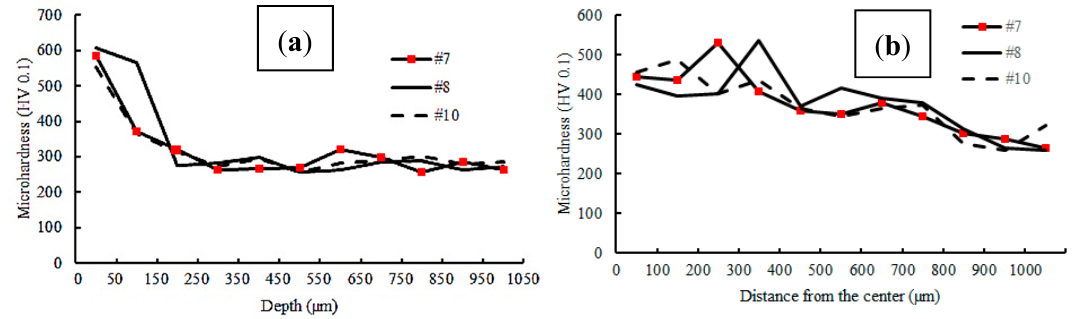
Figure 10. Micro-hardness profile in ( a ) depth and ( b ) width of the hardened laser layer (samples #7, #8, and #10); see Figure 2.